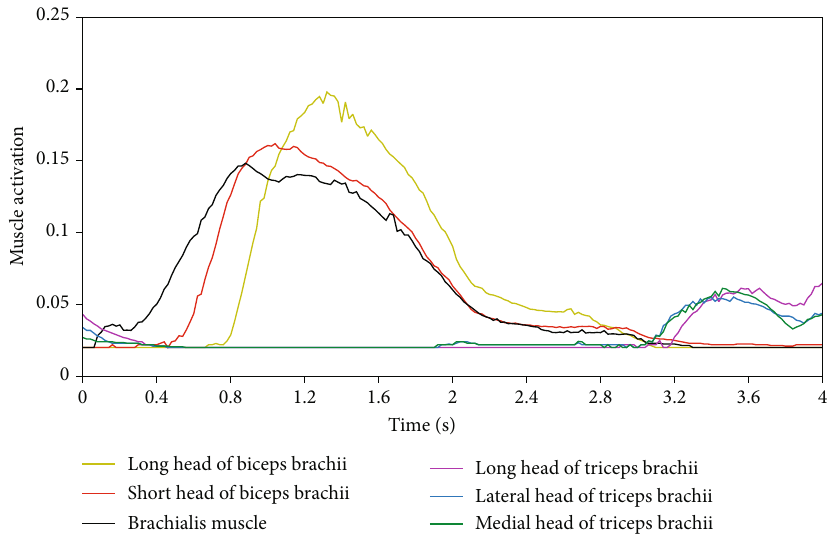
Figure 8: The related muscle activation obtained by